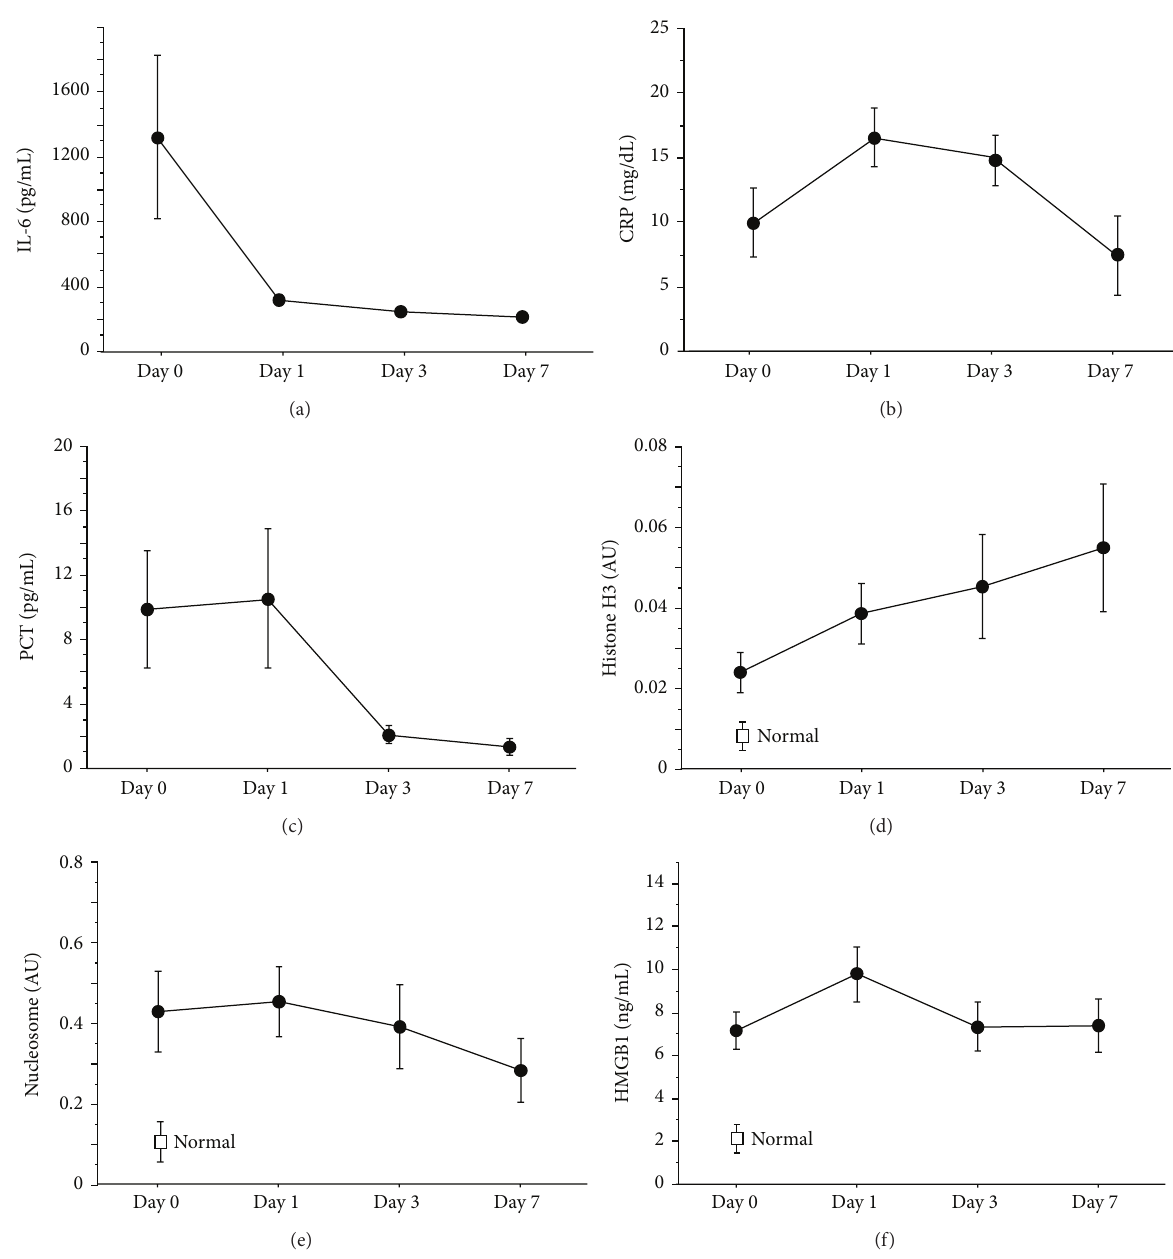
Figure 2: Changes of biomarkers. The time-courses of various biomarkers are plotted in the figure ((a) IL-6, (b) CRP, (c) PCT, (d) histone H3, (e) nucleosome, and (f) HMGB1). The levels of histone H3, nucleosome, and HMGB1 in healthy donors ( 𝑛 = 5 ) were also shown in (d), (e), and (f). The levels of IL-6, CRP, and PCT peaked on Day 1 or Day 3 and decreased thereafter. In contrast, the level of histone H3 increased along with the days and reached its maximum level on Day 7. Data are expressed as means ± standard error. AU: absorbance units, IL-6: interleukin 6, CRP: c-reacting protein, PCT: procalcitonin, and HMGB1: high-mobility group protein Box 1.